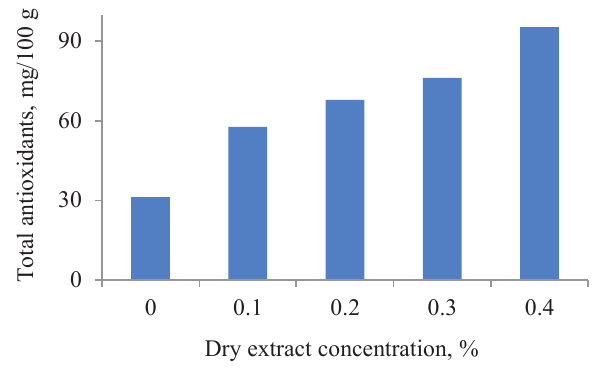
Figure 3 Total content of antioxidants in paste samples with different concentrations of dry lingonberry marc extract